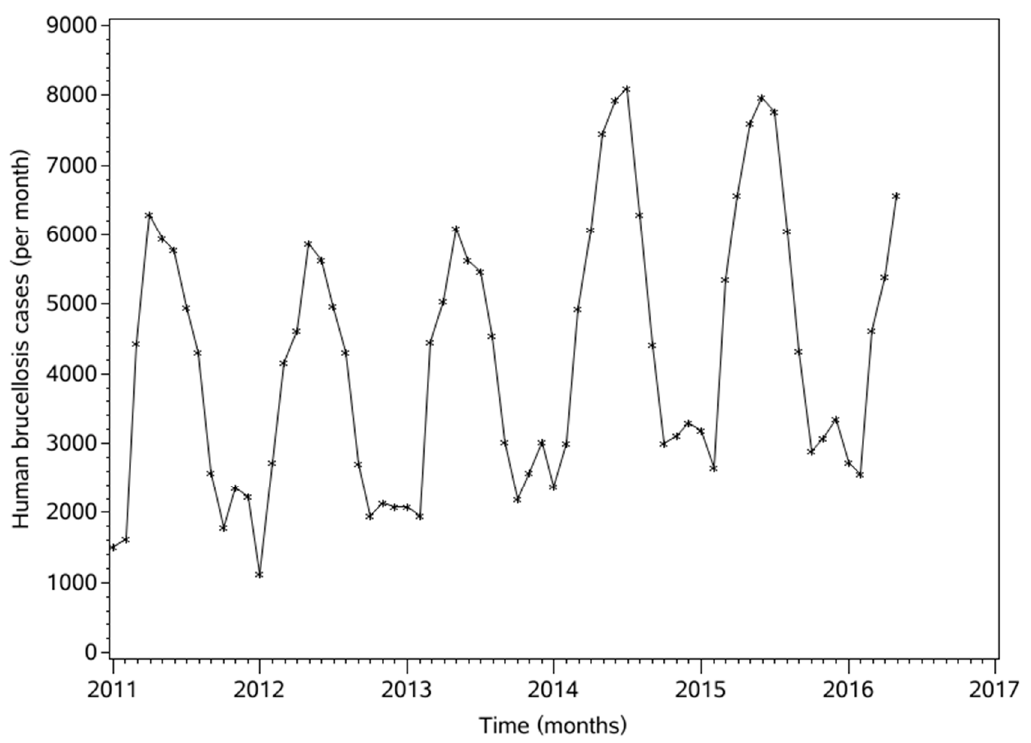
Figure 3. Trends in monthly human brucellosis cases.